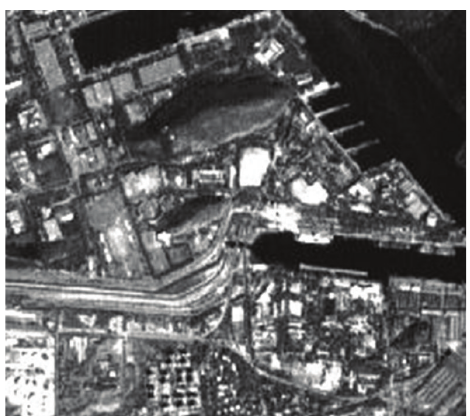
Figure 3: Original image size (cid:3) 264 × 414 × 3 (cid:4) .